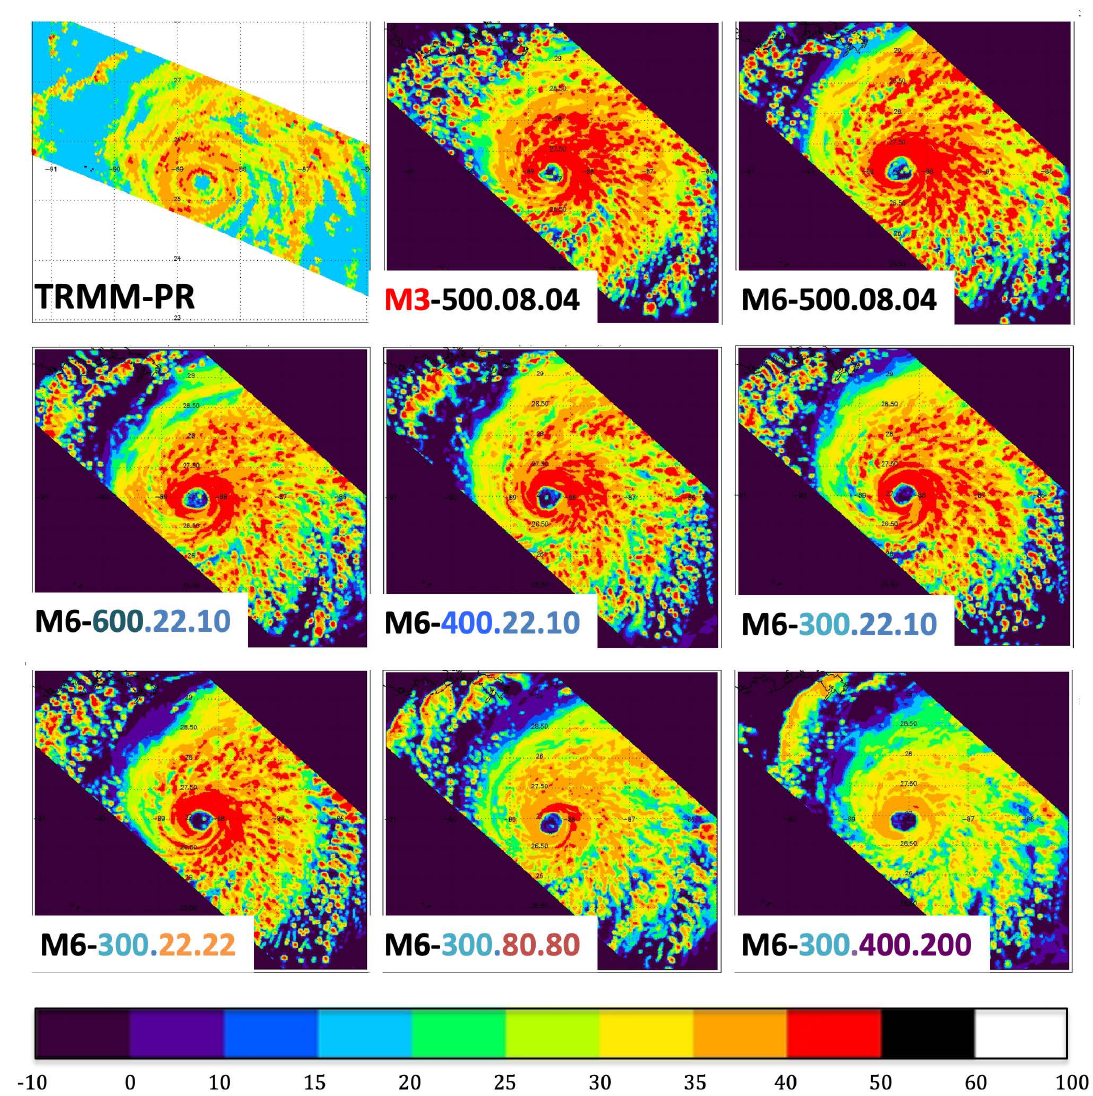
Figure 10. Maximum attenuated reflectivity as observed by the TRMM precipitation radar (PR) in the upper left and the corresponding synthetic data from the 8 simulations. The observations, and the eight different experiments, are arranged in the same order as in Figure